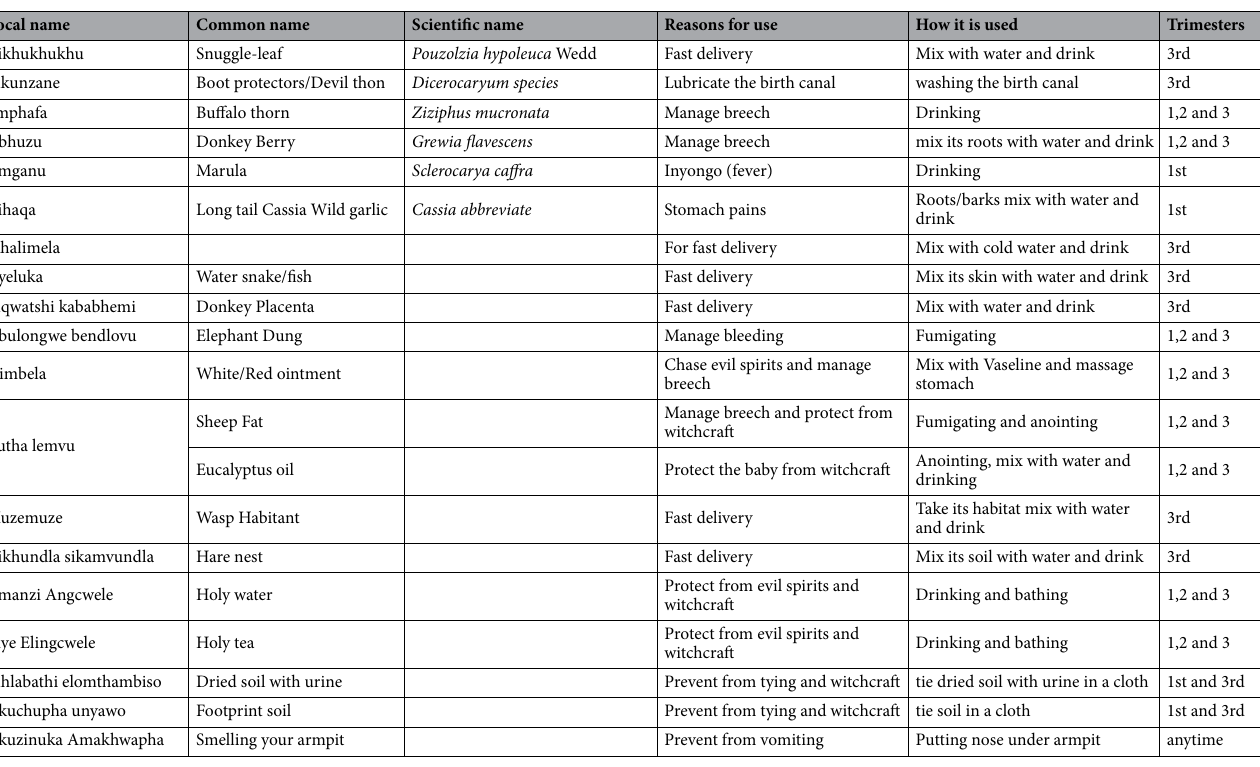
Table 2. Traditional medicine